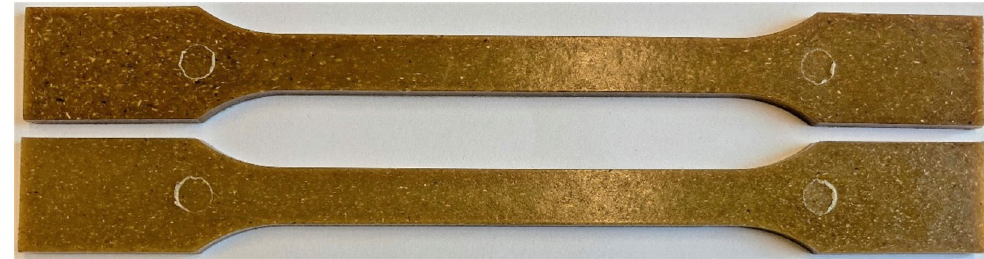
Figure 2. Test specimens of wood ‐ filled TPU. Top: TPU with 30 ‐ wt ‐ % Lignocel BK40/90, bottom: 30 ‐ wt ‐ % Arbocel C320.